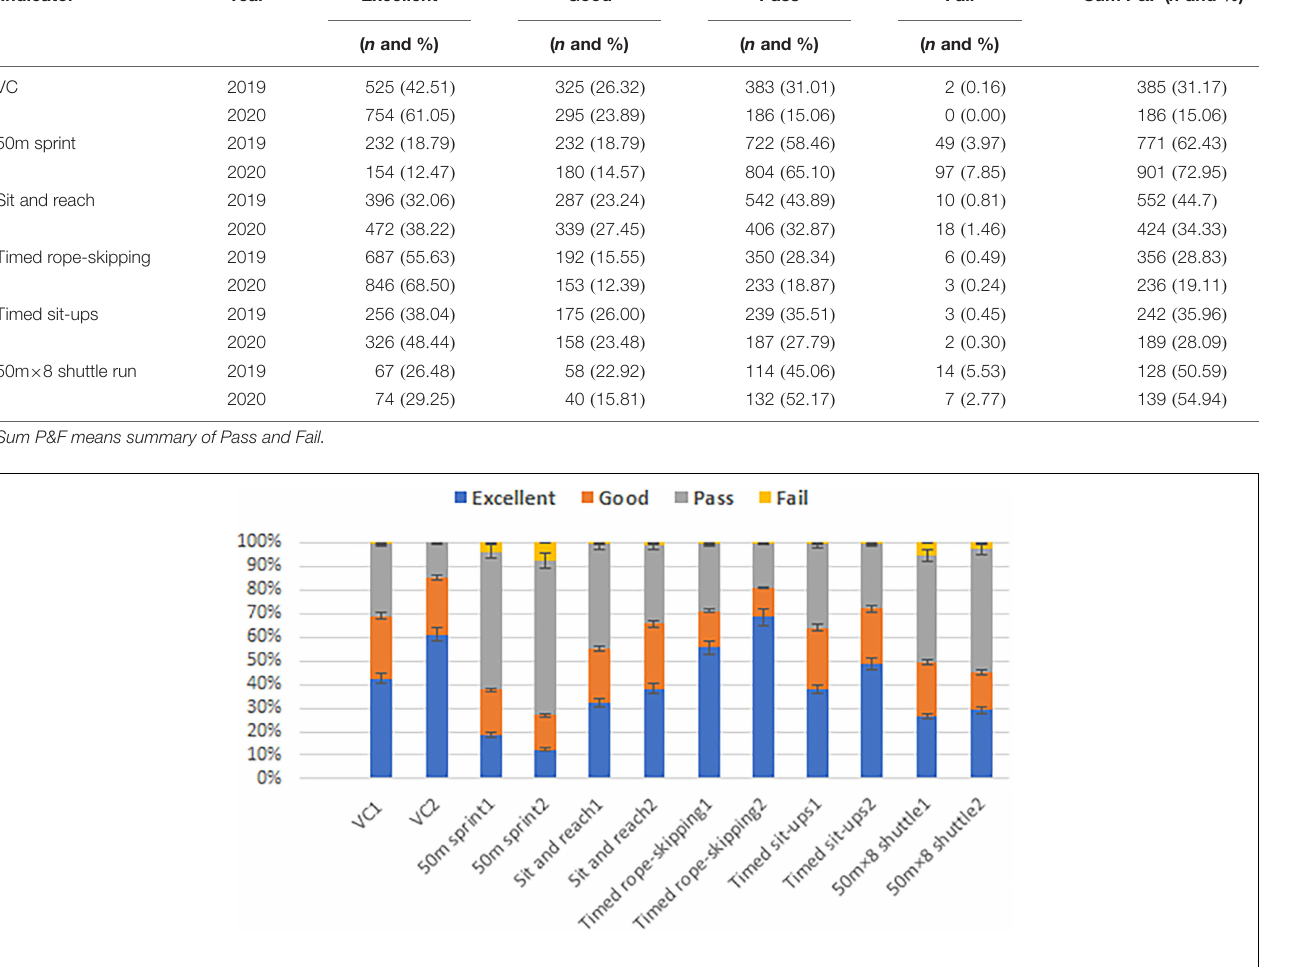
FIGURE 2 | Physical fitness rank distribution before and after the lockdown. 1-2019; 2-2020. TABLE 3 | Wilcoxon signed ranks test for all CNSPFS